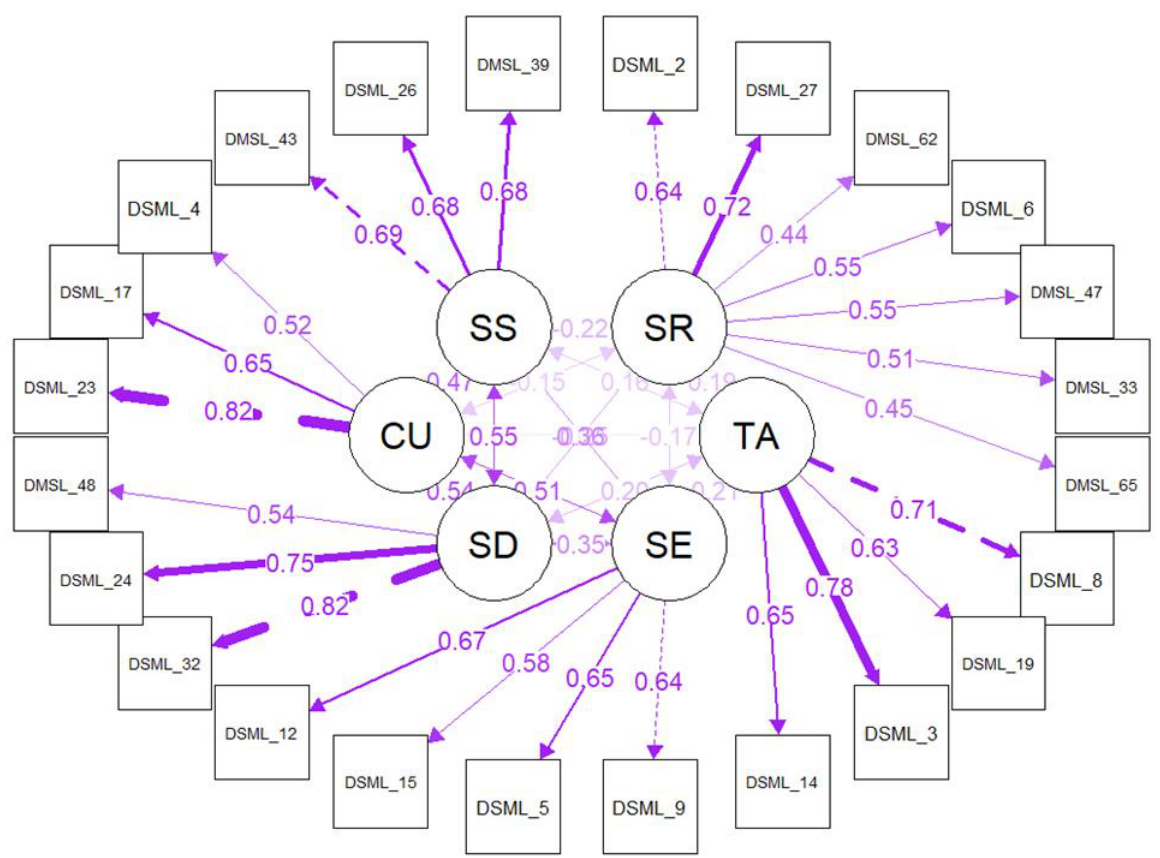
Figure 1. Between and within CFA loadings darker lines represent stronger factor